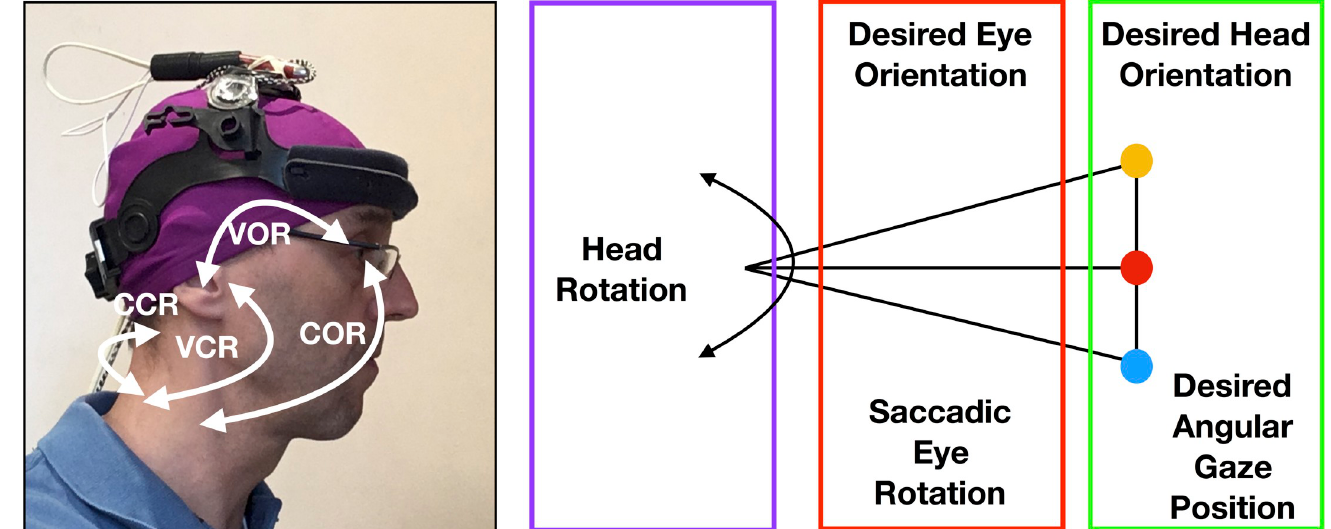
Fig 6. Cervico-collic reflex and flow of information. (A) illustration of reflexes connections associated with cervical afferents: cervico-collic reflex (CCR), cervico- ocular reflex (COR), vestibulo-cervical reflex (VCR) and vestibulo-ocular reflex. (B) flow of information in the DidRen Laser test. Red box shows the part of the model involved in computation of the saccadic eye rotation. Green box shows the part of the model which computes the total head rotation. Violet box shows the VOR predictor related to eye followed by head rotation. Each signal is computed from the signals that have inputs to it.